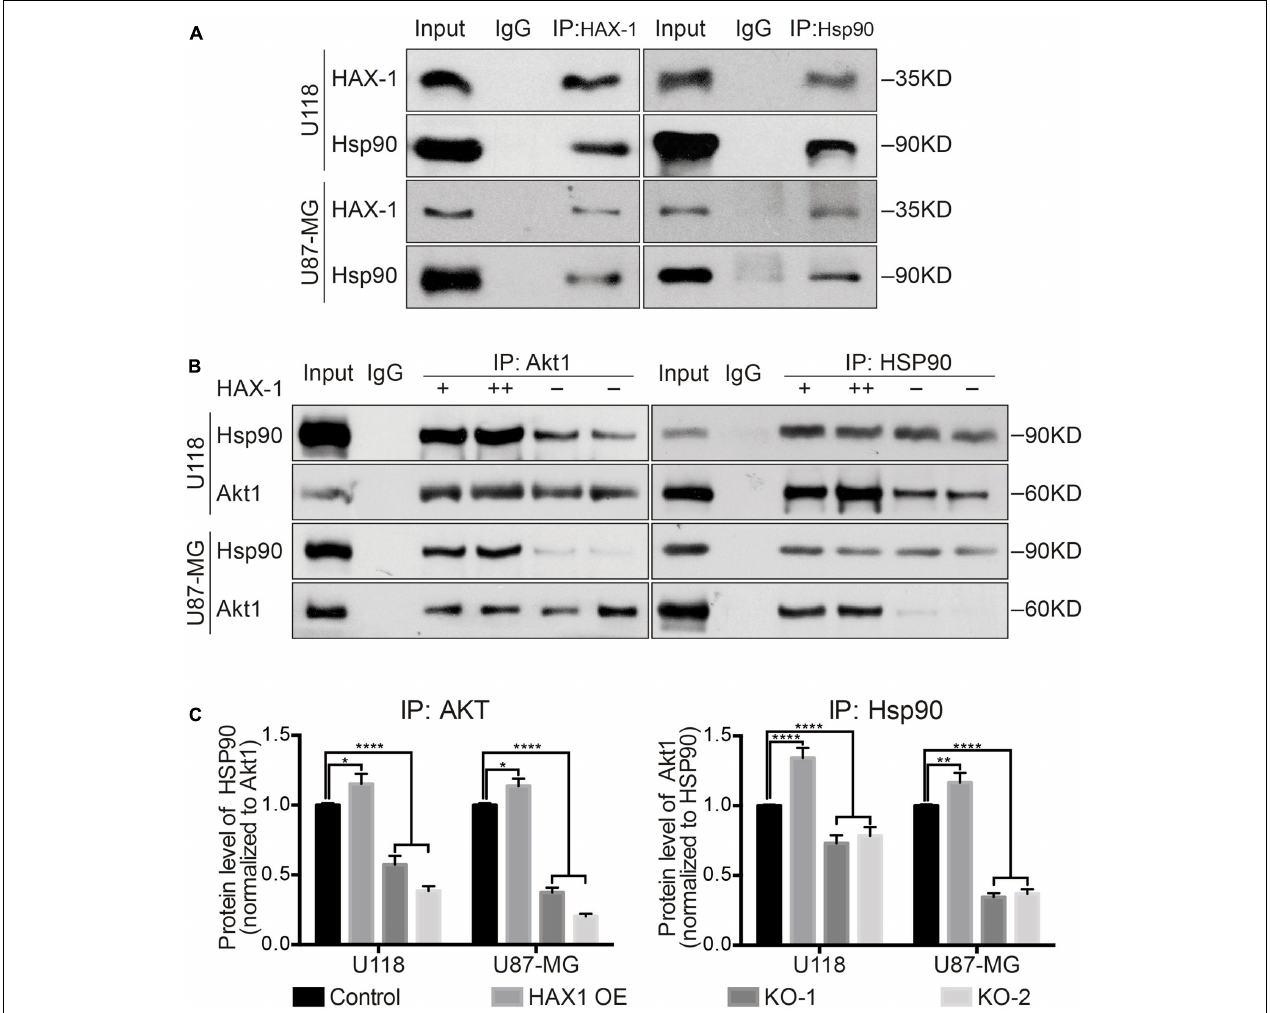
FIGURE 7 | HAX-1 influences the phosphorylation of Akt1 through interaction with Hsp90. (A) Co-IP showed HAX-1 combined with Hsp90 in U118 and U87-MG cell lines. (B,C) Co-IP exhibited that HAX-1 influenced the interaction between Hsp90 and Akt1. Three individual experiments were performed for each group. ∗ P < 0.05, ∗∗ P < 0.01, ∗∗∗ P < 0.001, ∗∗∗∗ P <